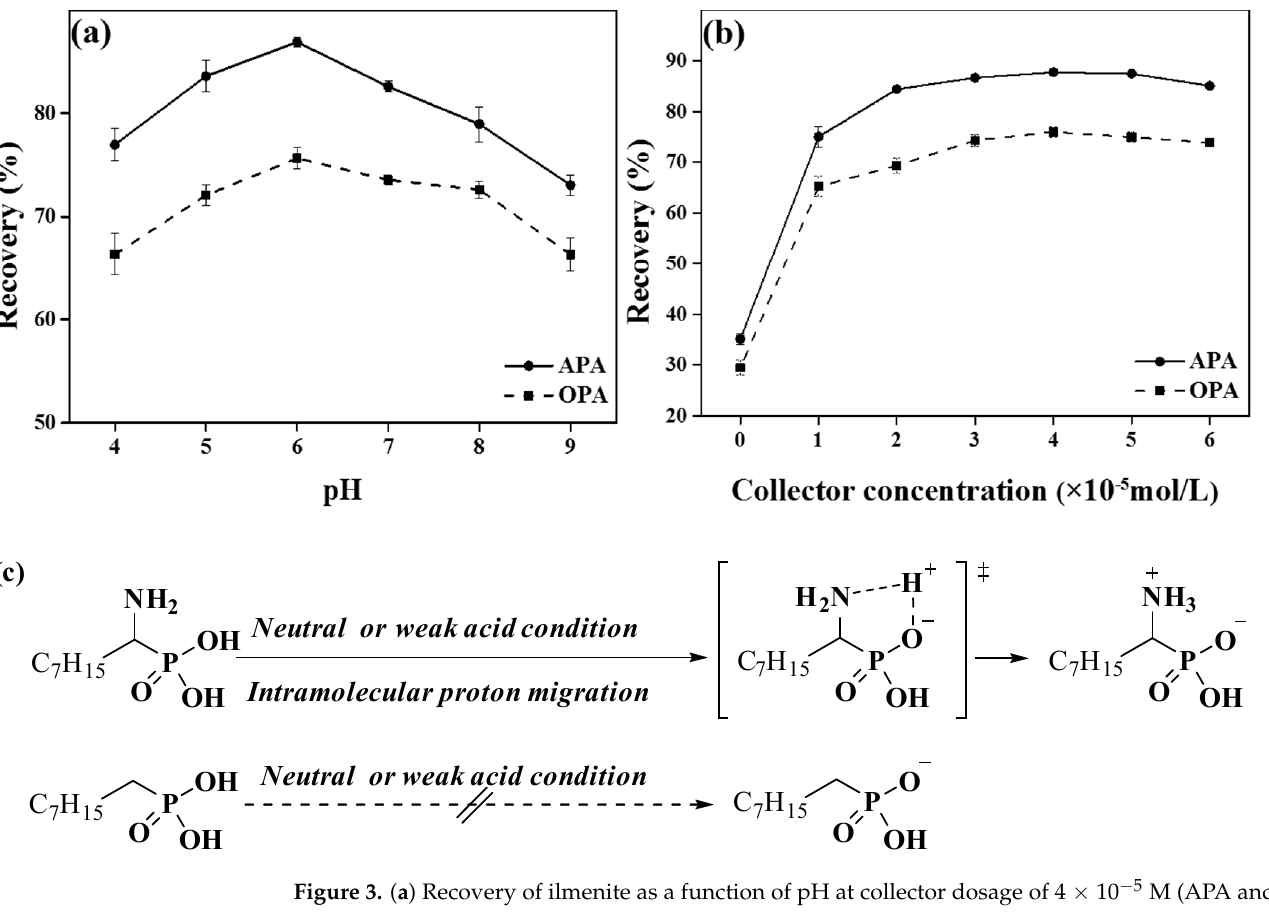
Figure 3. ( a ) Recovery of ilmenite as a function of pH at collector dosage of 4 × 10 − 5 M (APA and OPA were used as collector); ( b ) recovery of ilmenite as a function of collector dosage at pH 6 (APA and OPA were used as collector); ( c ) the proposed proton transfer process of APA at natural or weak acid condition.